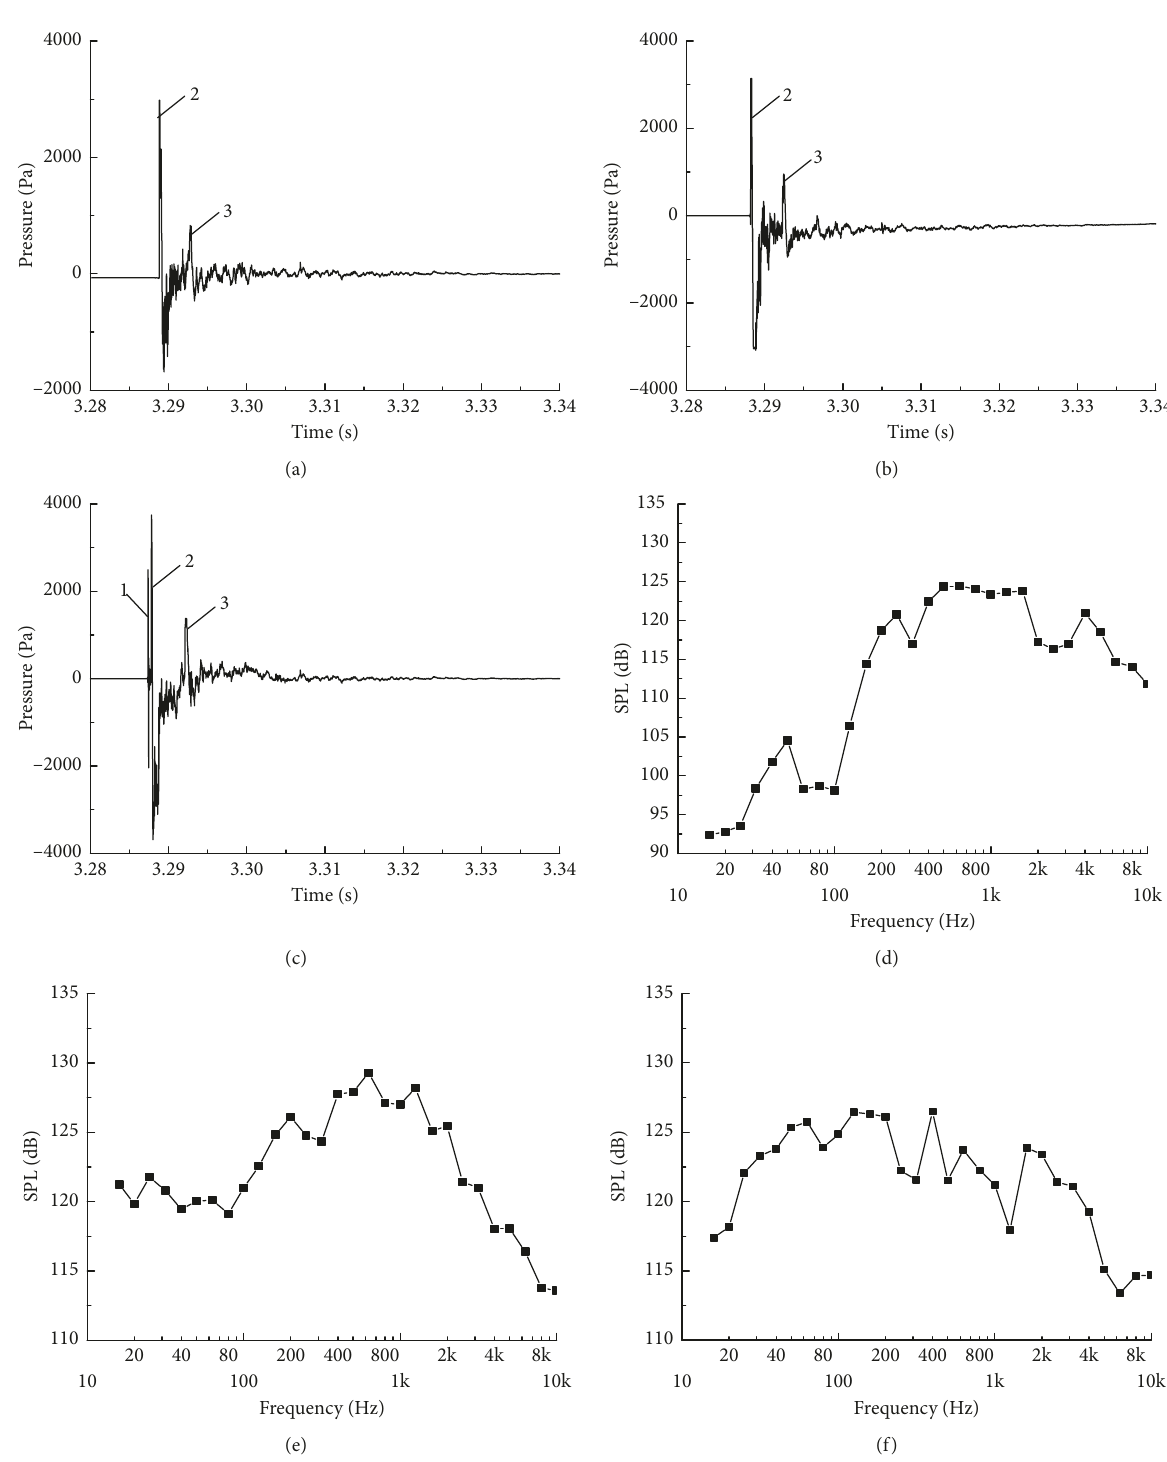
Figure 7: Sound pressure level varying with time and the corresponding one-third octave frequency spectrum at different measurement points. (a) P - T at point 1. (b) P - T at point 5. (c) P - T at point 9. (d) SPL- f at point 1. (e) SPL- f at point 5. (f) SPL- f at point 9. 1: initial shock wave; 2: muzzle blast; 3: impulse noise